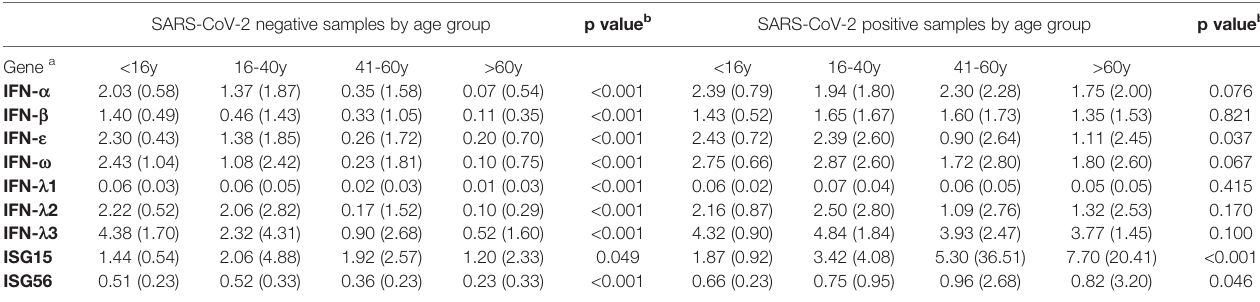
TABLE 2 | Gene expression results of study samples (N=192) strati fi ed by SARS-CoV-2 infection and age group. SARS-CoV-2 negative samples by age group